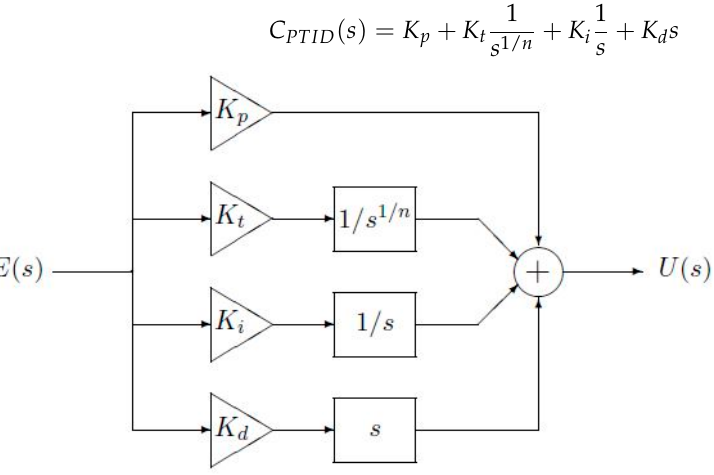
Figure 3. PTID controller structure.